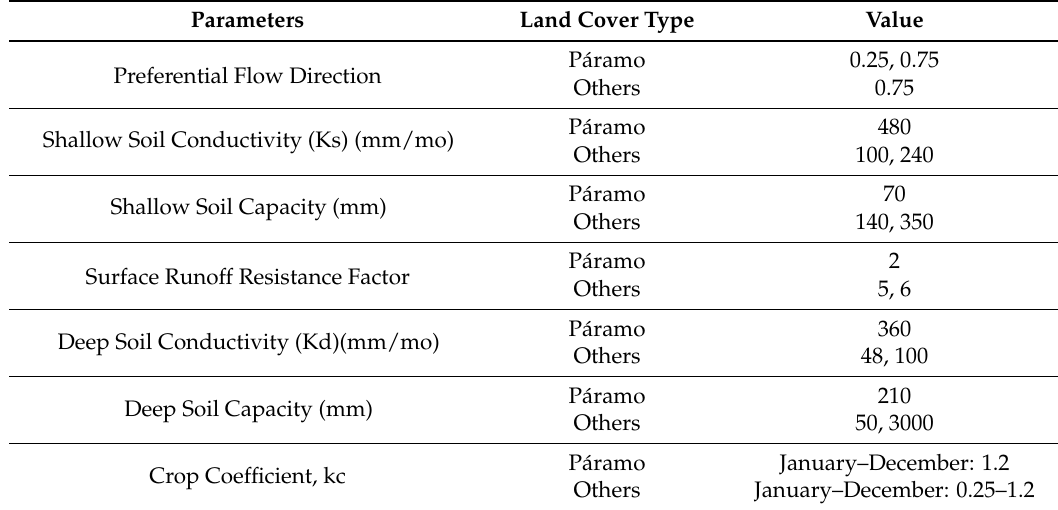
Table 5. Calibrated parameters used on the Quiroz-Chipillico watershed model. Parameters